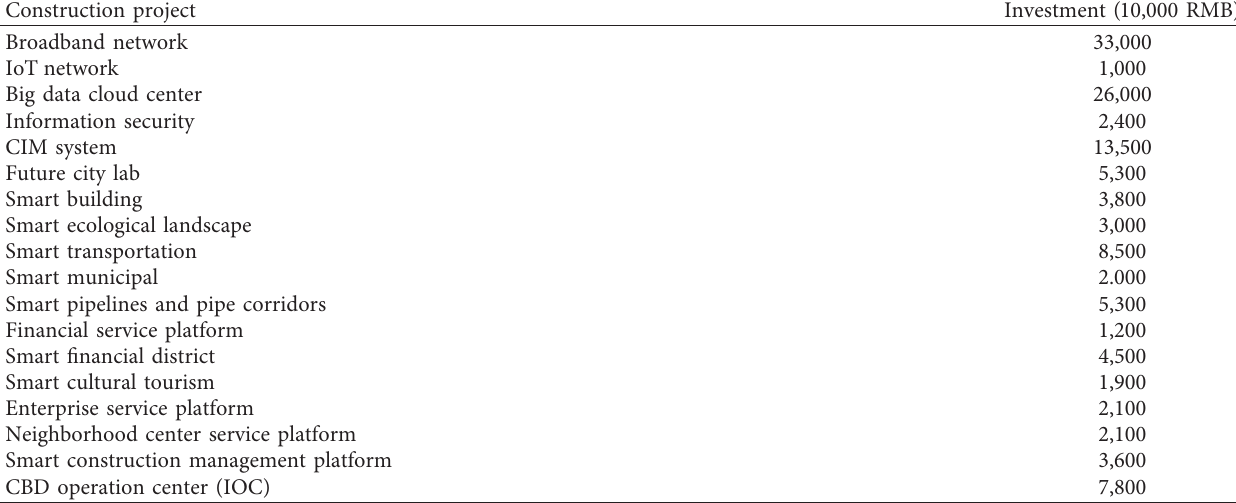
Table 7: Estimates of smart construction projects in the CBD of the Jiangbei New District (2019–2023).